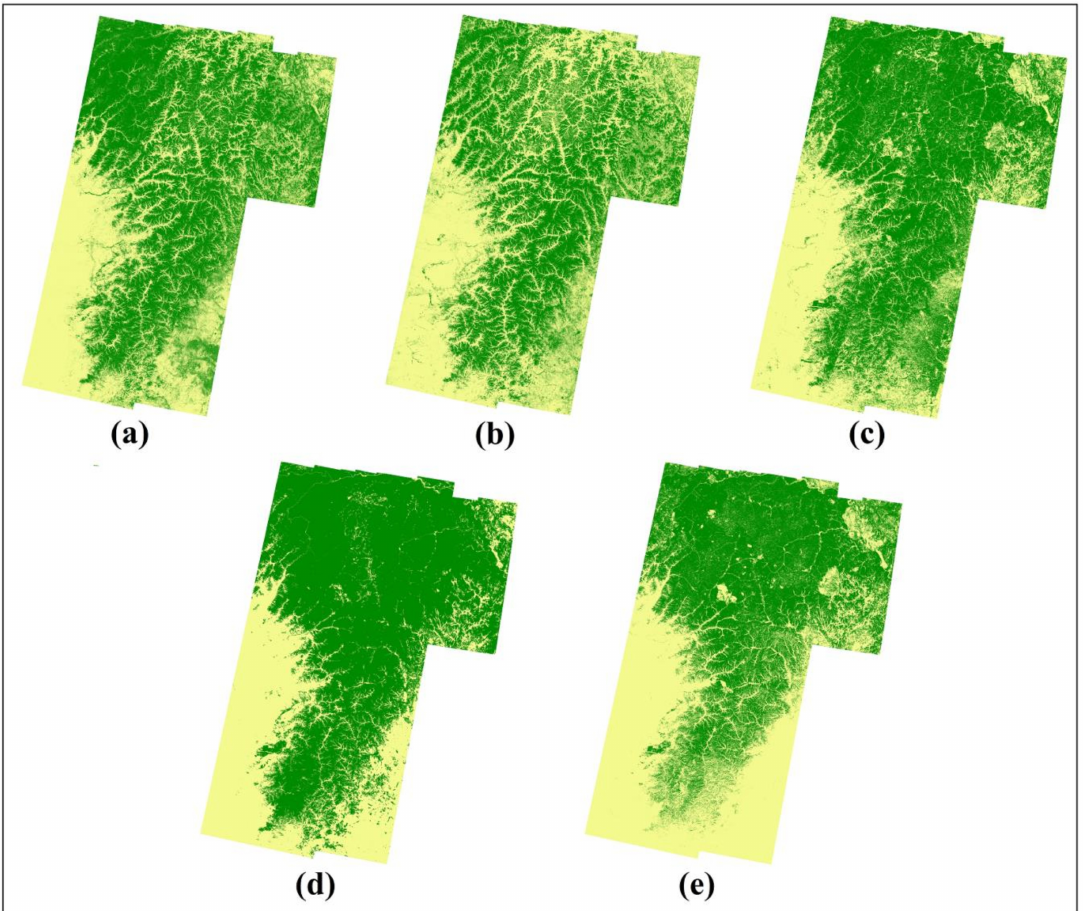
Figure 14. Forest maps: ( a ) The map derived by the direct method using Sentinel-1 data of 2015; ( b ) The map derived by the direct method using Sentinel-1 data of 2018; ( c ) Finer Resolution Observation and Monitoring of Global Land Cover (FROM-GLC); ( d ) ALOS / PALSAR forest / non-forest; ( e ) Landsat Global Forest Cover Change (GFCC) dataset. Green: forest, Yellow: